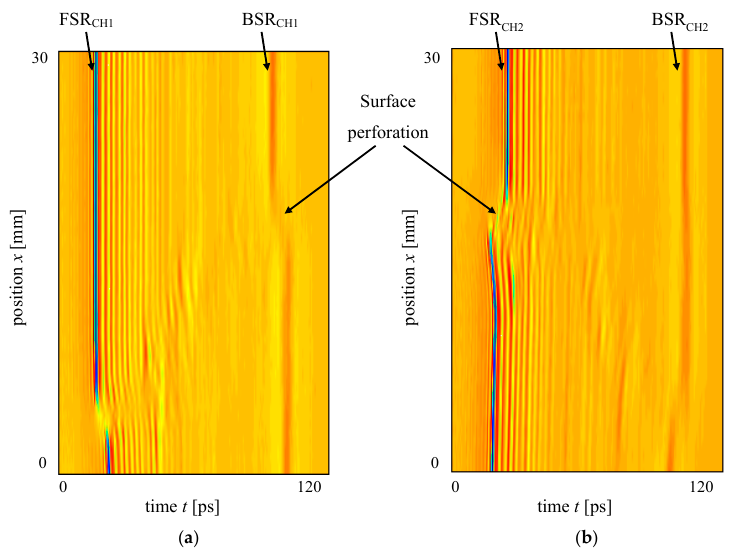
Figure 11. Exemplary B-scan signals obtained using double-sided inspection of a composite sample subjected to stress: ( a ) deconvolved channel 1 signal g mCH1 ( t , x ); and ( b ) deconvolved channel 2 signal g mCH2 ( t , x ).